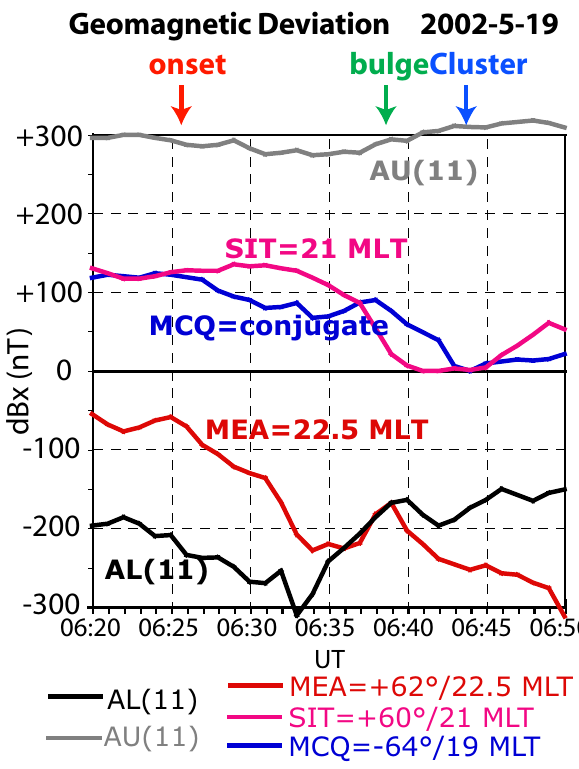
Fig. 3. The provisional AU and AL indices from 11 stations and geomagnetic deviation X-component from three stations during 06:20 ∼ 06:50UT on 19 May 2002. The numbers given after each station’s code at the bottoms are the corrected geomagnetic latitude and the magnetic local time. Note that the corrected geomagnetic latitude is sometimes different from the dipole geomagnetic latitude by up to 4 ◦ (MCQ is − 60 ◦ in the dipole coordinate). MCQ is also the nearest conjugate of Cluster (only 5 ◦ off in magnetic longitude and 1 ◦ off in magnetic latitude) during this period. The timings of “onset” and “bulge” in the figure are determined by IMAGE/FUV auroral image in Fig. 4, and the event “Cluster” is the time when Cluster detected large change in Fig. 1.